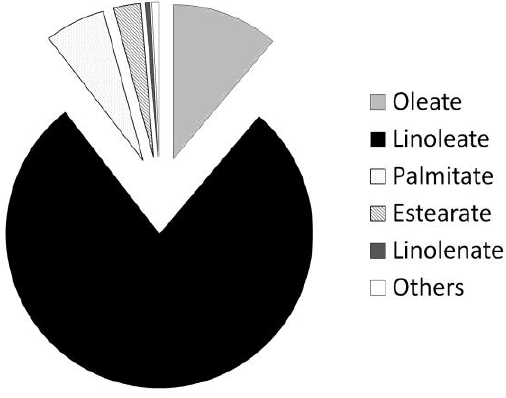
Figure 3. FAME profile for safflower biodiesel.